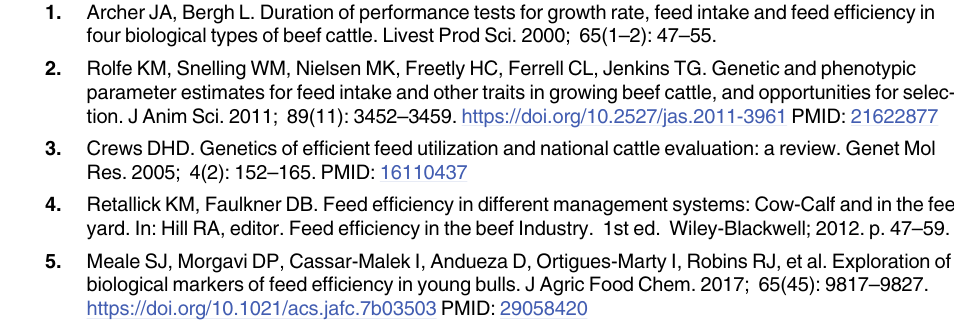
S1 Fig. Partial least square discriminant analysis (PLS-DA) for residual feed intake (RFI) on the basis of: a) total metabolomic dataset (3,457 ions) or b) only confirmed metabolites (anno- tation class 1). Score plot, and cross validation values are presented in the top and bottom of each figure panel, respectively. Red and green dots depict Low- and High-RFI,